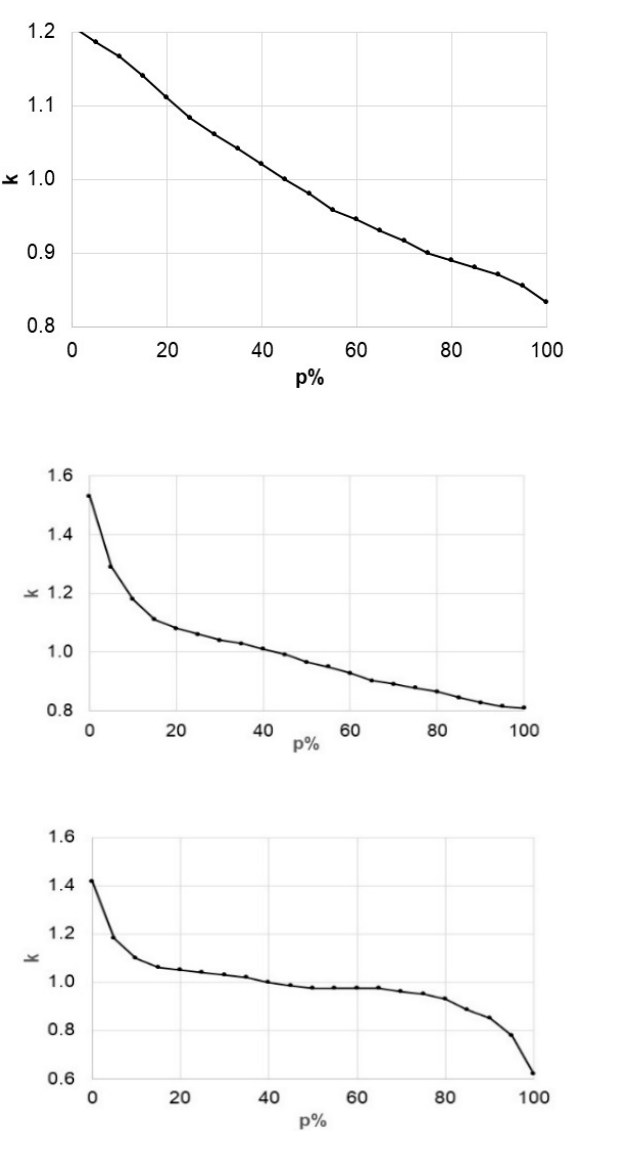
Figure 8. Normalized FDCs (from left to right ): Kaunas 1, Kaunas 2, Kaunas WWTP, Vilnius WWTP, Vilnius PRV, and Alytus WWTP; k —normalized flow; p —percentage of time equaled or exceeded.